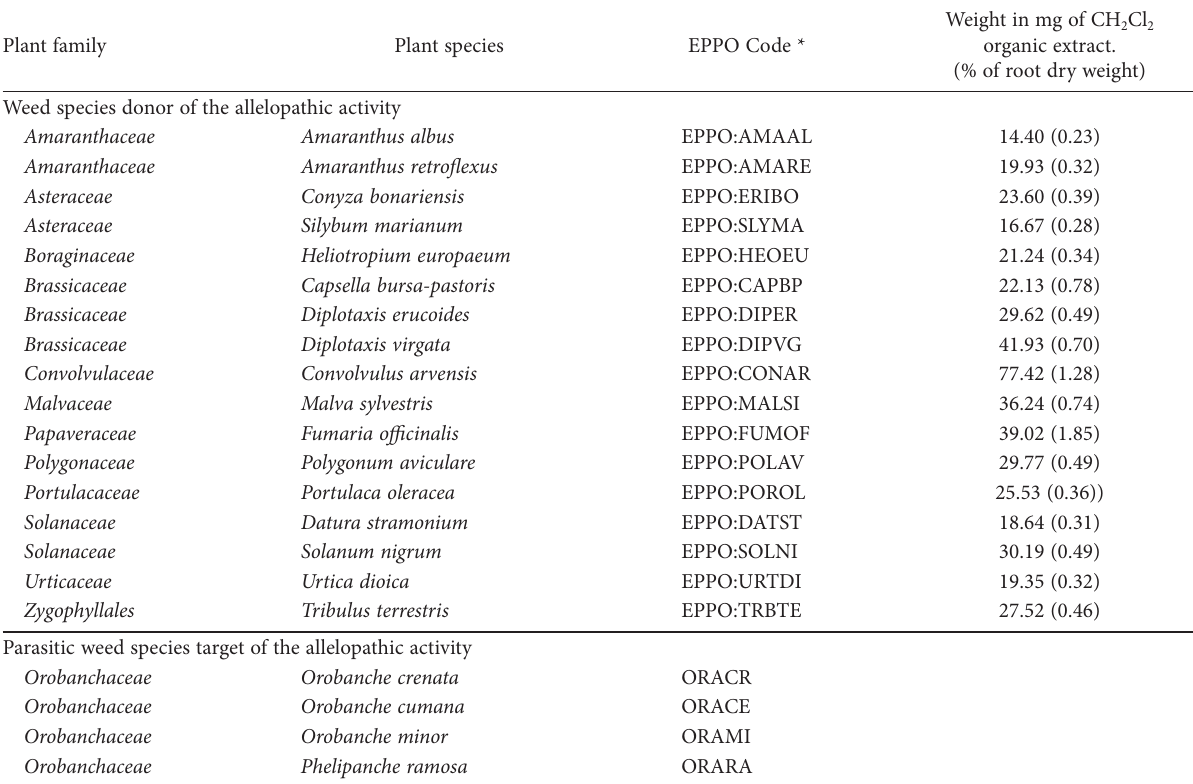
Table 1. Weed species investigated for root allelopathic activity against four broomrape species, and mean yields of organic extracts from the CH 2 Cl 2 extractions from dry